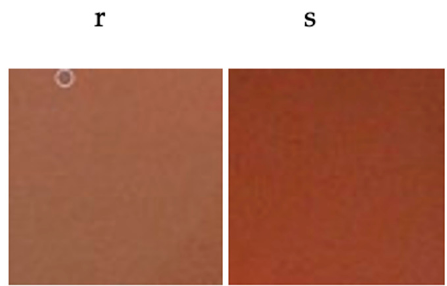
Figure 15. Color development of glazed tiles with pigment Y 0.98 Al 0.98 Cr 0.04 O 3 with flux agent mixture